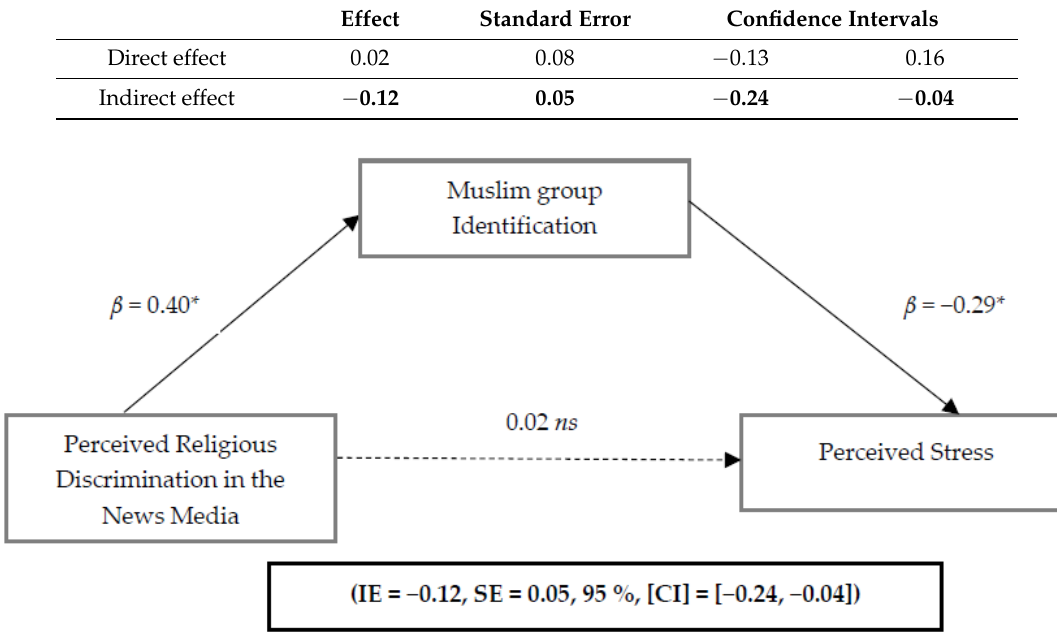
Figure 1. Negative indirect effect of perceived religious discrimination in the news media on perceived stress through Muslims’ identification with their group (Note * p < 0.001; IE = indirect effect; CI = Confidence